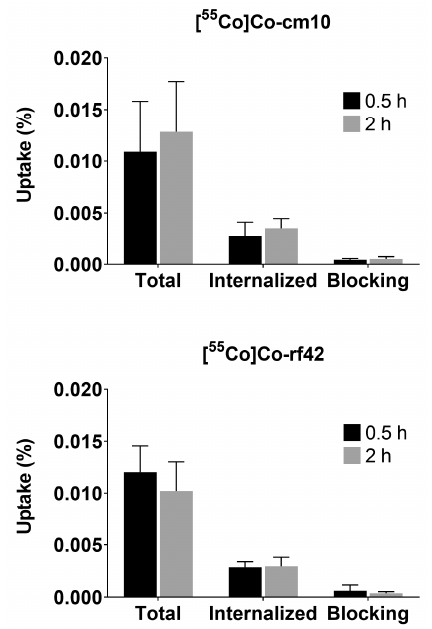
Figure 3. Uptake and internalization of (top) [ 55 Co]Co-cm10 and (bottom) [ 55 Co]Co-rf42 in KB tumor cells. Blocking was performed by co-incubation with 0.7 mM of folic acid.